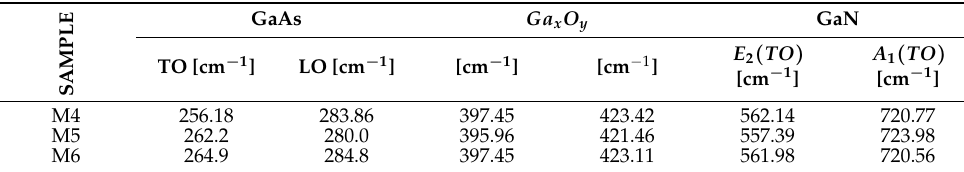
Figure 7. Raman spectra for the nitrided samples M4, M5, M6. Table 4. Peaks position of the modes in Raman spectra of each nitrided